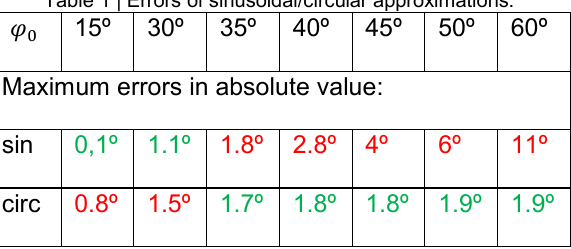
Table 1 | Errors of sinusoidal/circular approximations.